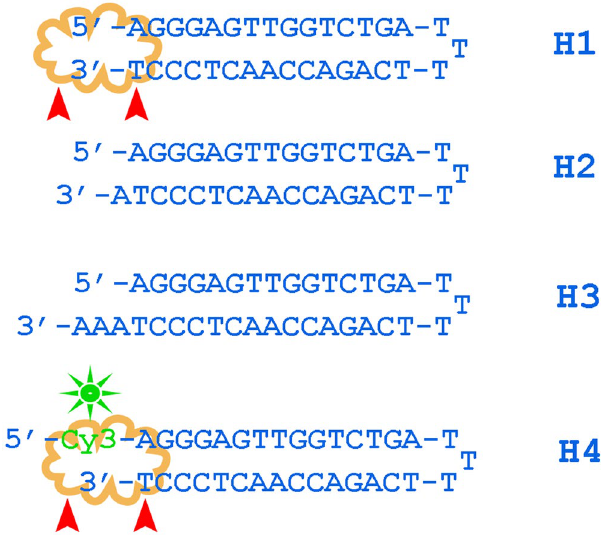
Figure 5. Oligonucleotide hairpin models for studying 3 ′ -tailing and terminal nucleotide exchange: blunt- ended hairpin H1, single dA 3 ′ -overhang in H2, triple dA 3 ′ -overhang in H3, and 5 ′ -Cy3 labeled hairpin H4.